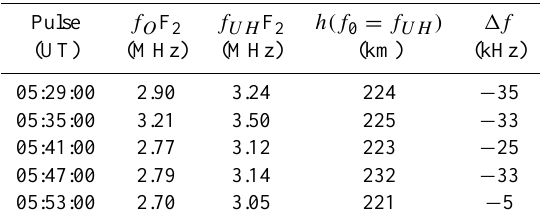
Table 2. Table 2 show the most HF-pump-relevant ionospheric pa- rameters. Here we have calculated f O F 2 and f UH F 2 as the highest plasma and upper-hybrid frequency in all four PFISR beams. Iono- spheric